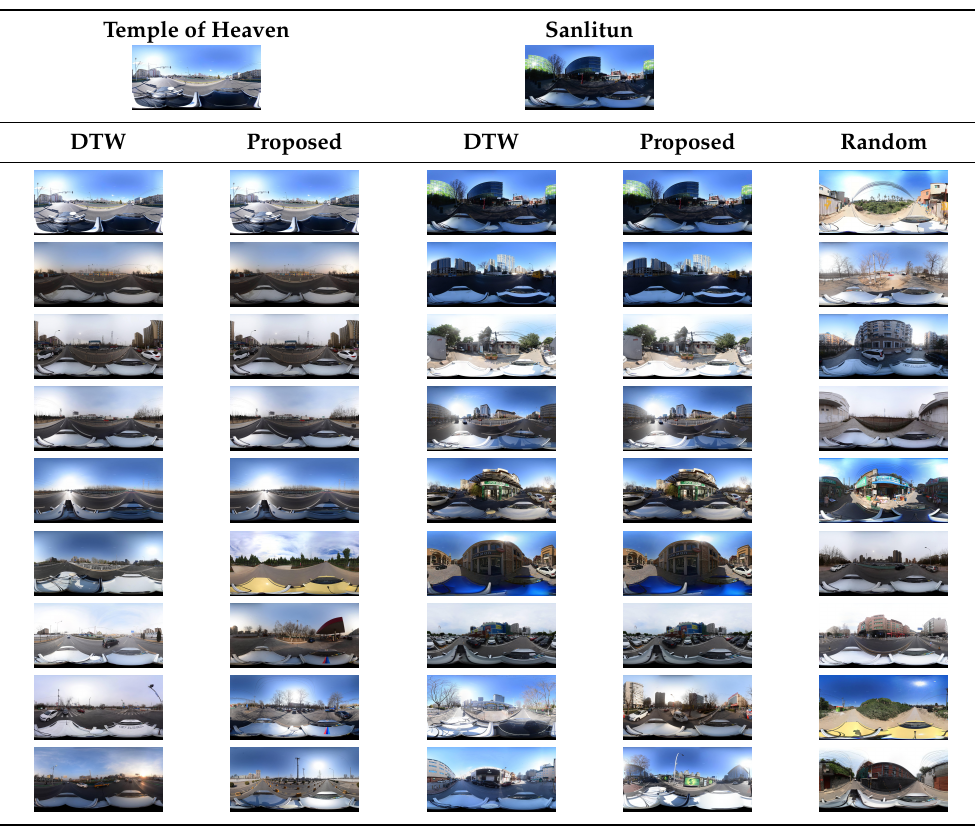
Figure 9. Offset distance between the spatial distributions of TAZs retrieved from the proposed method and the reference method. ( a ) Distribution of the offset distance between top-10 strictly similar time series from the two methods; ( b ) Distribution of the offset distance between top-50 strictly similar time series from the two methods; ( c ) Distribution of the offset distance between top-100 strictly similar time series from the two methods; ( d ) Distribution of the offset distance between top-10 time series with a similar trend from the two methods; ( e ) Distribution of the offset distance between top-50 time series with a similar trend to the two methods; ( f ) Distribution of the offset distance between top-100 time series with a similar trend from to two methods. Table 3. Street-views of TAZs retrieved by DTW and the proposed